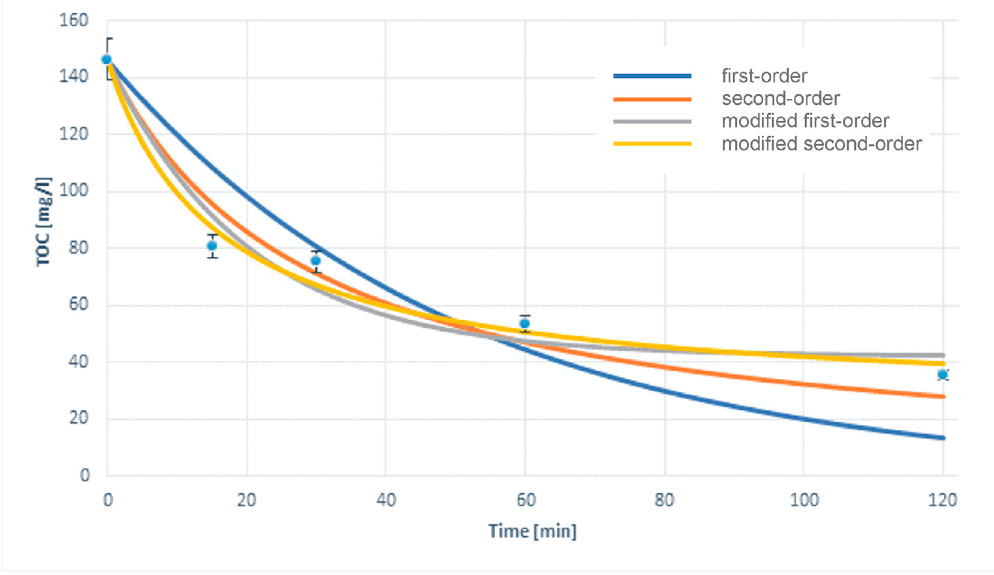
Figure1. Kineticmodelmatchingresultsforcosmeticwastewatertreatmentusinglight / Fe 2 O 3 / Fe 0 / H 2 O 2 , Figure 1. Kinetic model matching results for cosmetic wastewater treatment using 750 mg / L Fe 0 , 250 mg / L Fe 2 O 3 , and 1:1 H 2 O 2 / COD light/Fe 2 O 3 /Fe 0 /H 2 O 2 , 750 mg/L Fe 0 , 250 mg/L Fe 2 O 3 , and 1:1 H 2 O 2 /COD ratio.